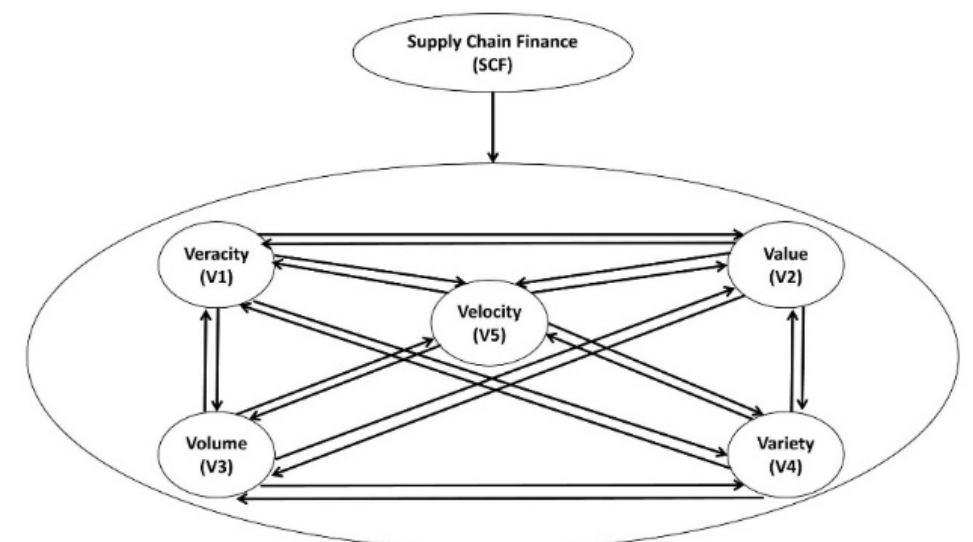
Figure 3. Conceptual fuzzy analytic network process model for supply chain finance and the 5 Vs of big data.